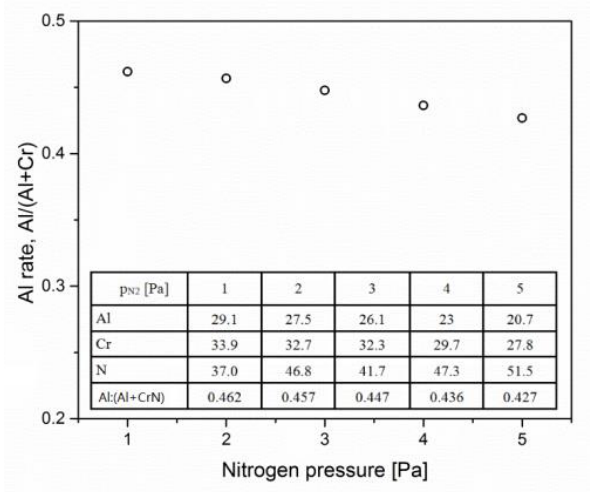
Figure 5. Al rate in AlCrN coatings deposited at temperature of 350 ◦ C, negative substrate bias voltage 100 V and various nitrogen pressure. Insert—chemical composition (at.%) of coatings